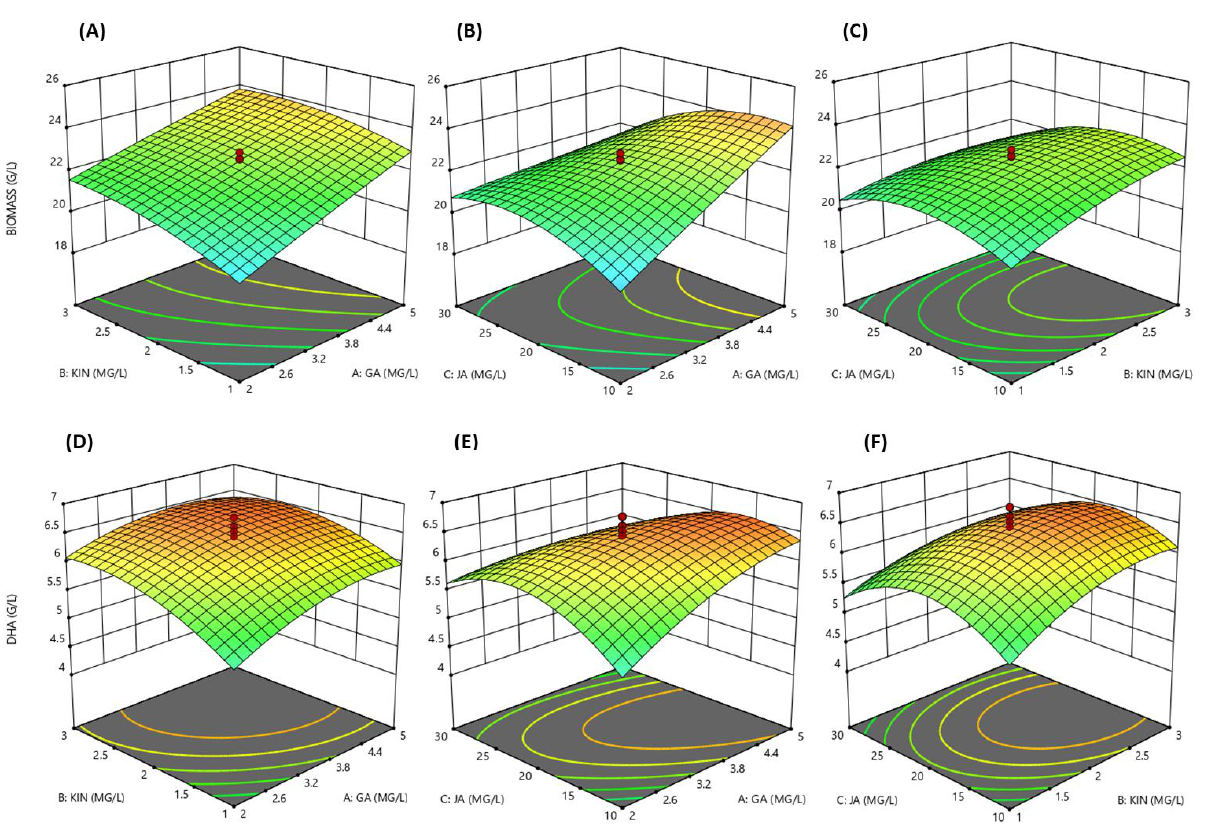
Figure 2. 3D response surface visualization for the synergistic effect of KIN, JA and GA on biomass ( A – C ) and DHA ( D – F ) production by SW1.